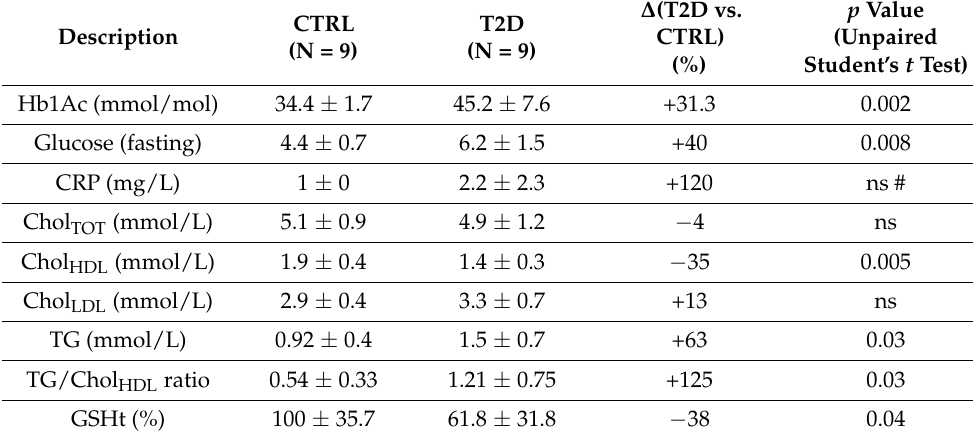
Table 2. Values of circulating blood markers (glycated hemoglobin—Hb1Ac, C-reactive protein—CRP, total cholesterol—Chol TOT , HDL cholesterol—Chol HDL , LDL cholesterol—Chol LDL , triglycerides—TG, total glutathione—GSHt). Data for each parameter were compared between the two groups using